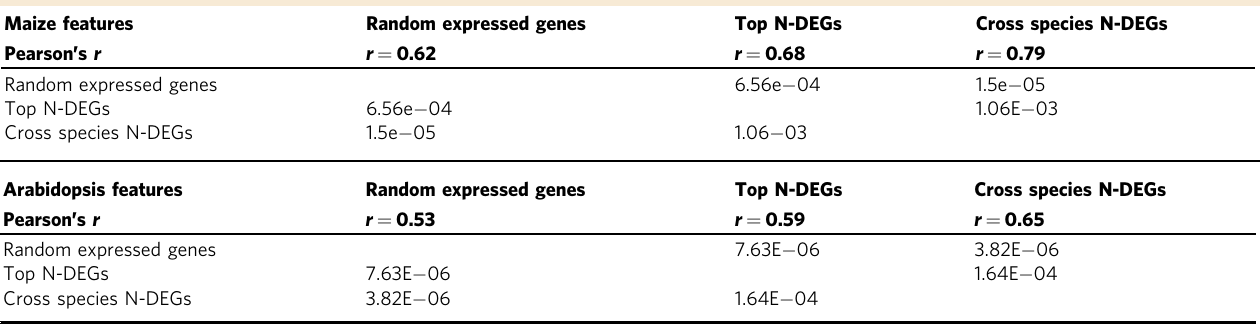
Table 1 Evolutionary conservation of gene responsiveness enhances machine learning outcomes. Maize